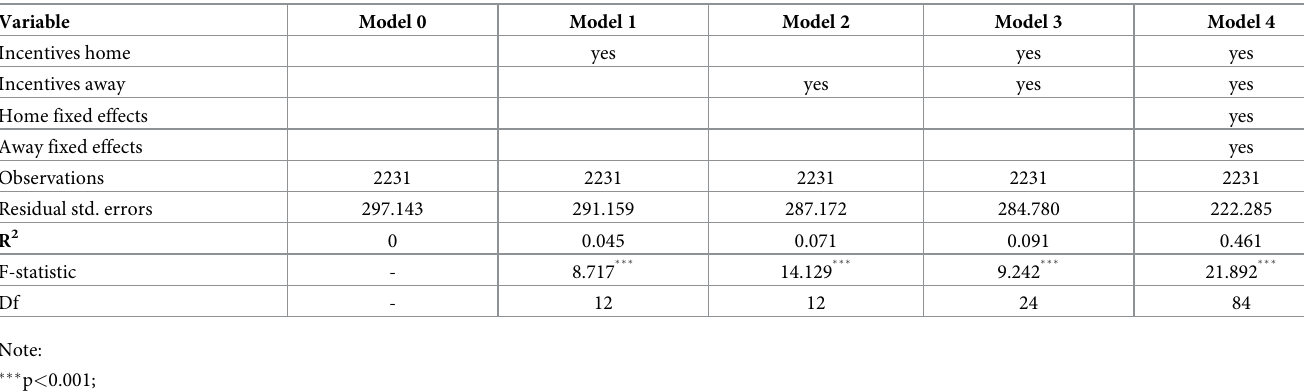
Table 2. Systematic components of effective playing time.